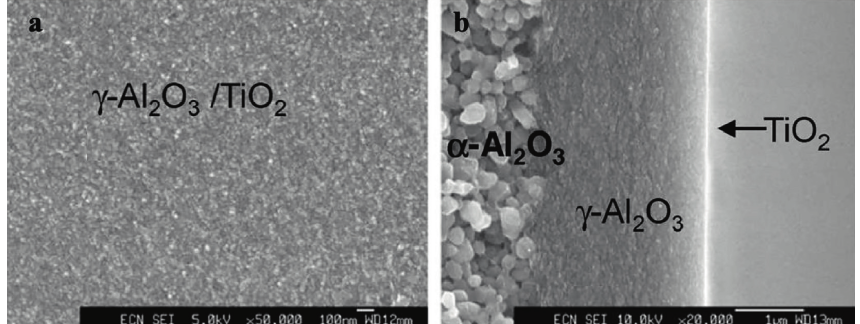
Figure 17: SEM images of c -Al 2 O 3 /TiO 2 membrane using PE-ALD: (a) top surface and (b) cross section